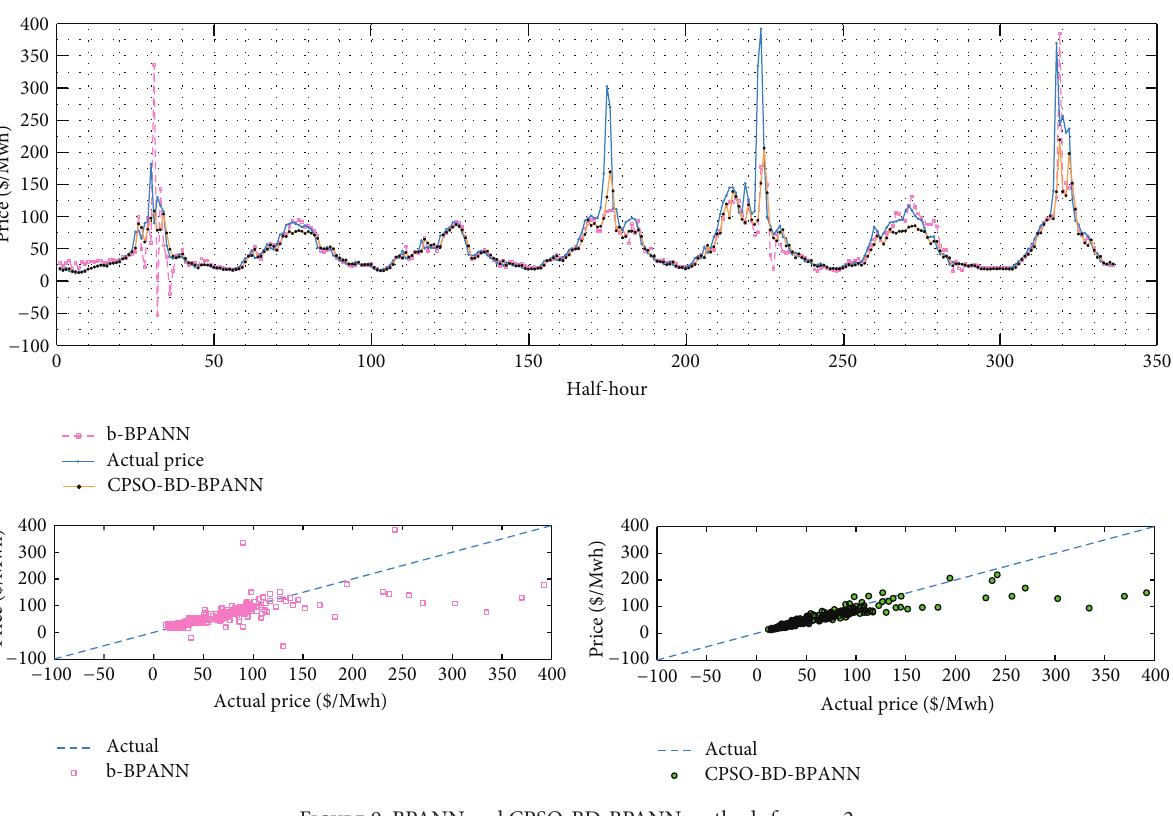
Figure 9: BPANN and CPSO-BD-BPANN methods for case 2.